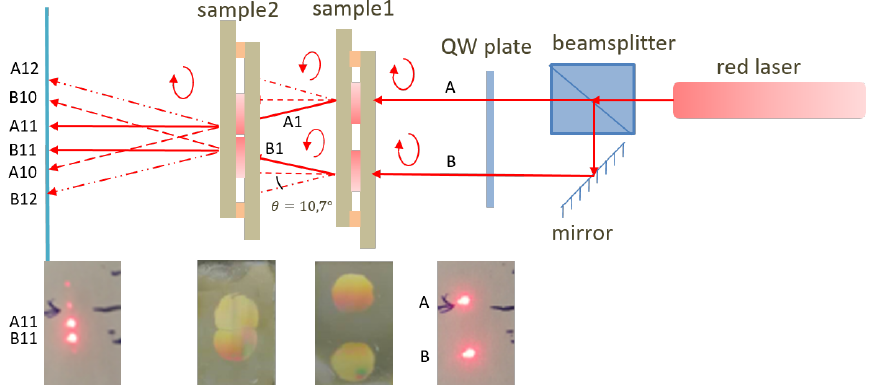
Figure 6. Top view of the set-up showing the beam combiner functionality based on two LC phase gratings (samples 1 and 2). A beam splitter is used to make two parallel beams A and B. The combination of samples 1 and 2 brings the parallel beams closer to each other. Six beams arriving on the screen are identified with a code (A10 to B12). The images at the bottom show pictures of the samples, and of the laser spots on the screen, in the absence and presence of the beam